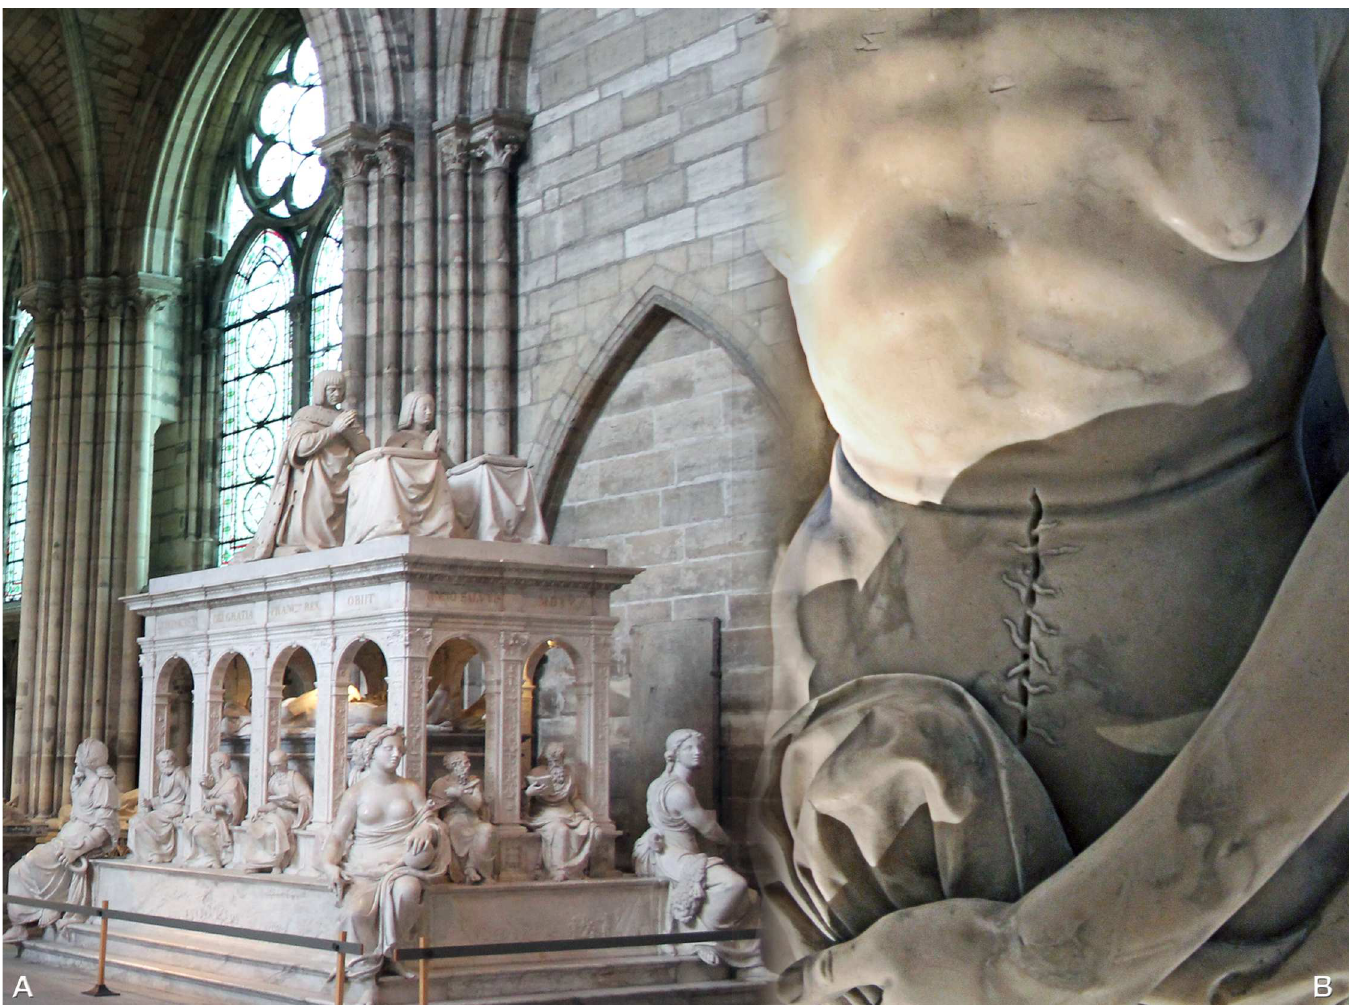
Fig 11. The funerary monument to Louis XII and Anne de Bretagne. (A) Basilica of Saint Denis. (B) Detail photographof the incisionon the Queen’s